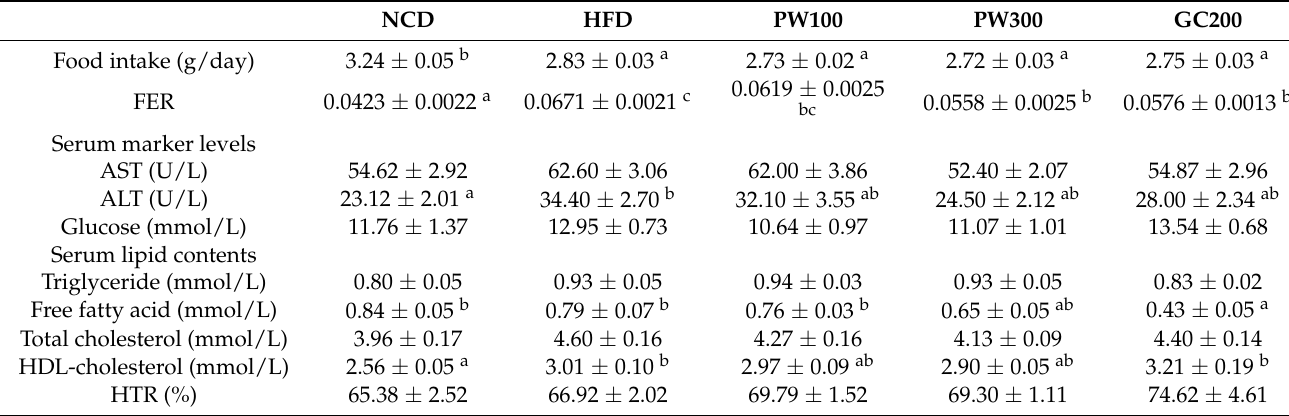
Table 2. Effects of Polygonum multiflorum Thunb. hot water extract on food intake, food efficiency ratio, serum marker levels, and lipid contents in HFD diet-induced obese mice.